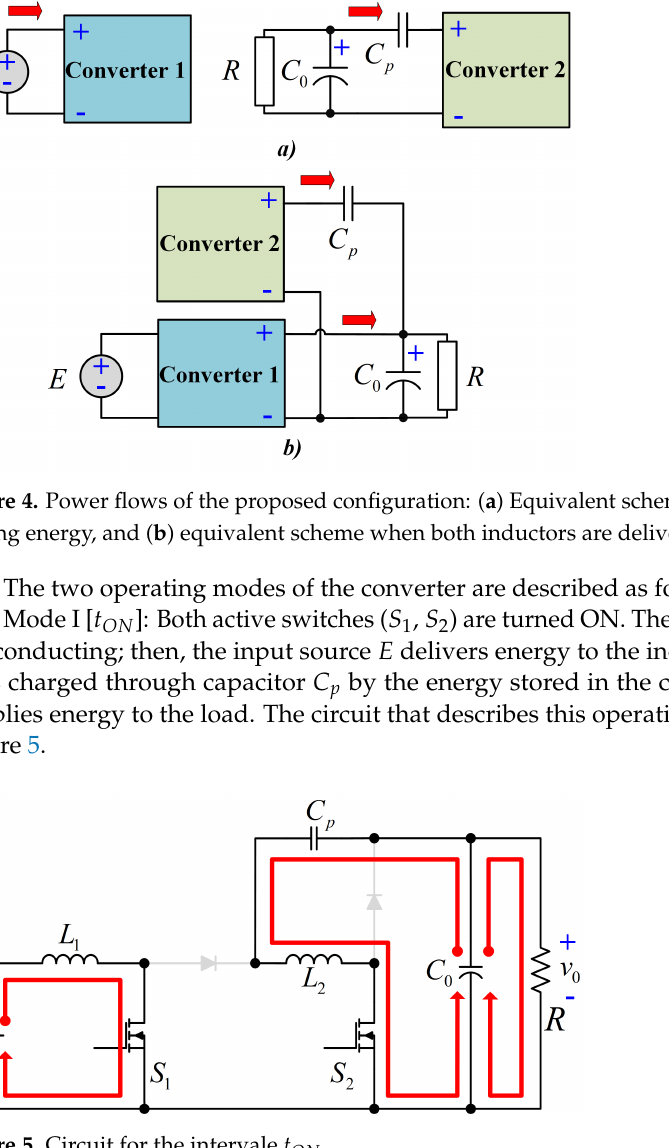
Figure 5. Circuit for the intervale t ON